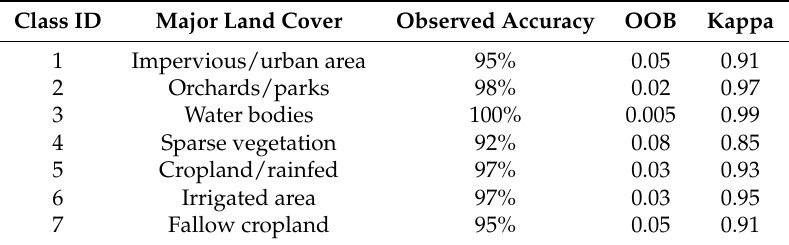
Table 3. RF model prediction indicators. OOB, Out Of Box error.